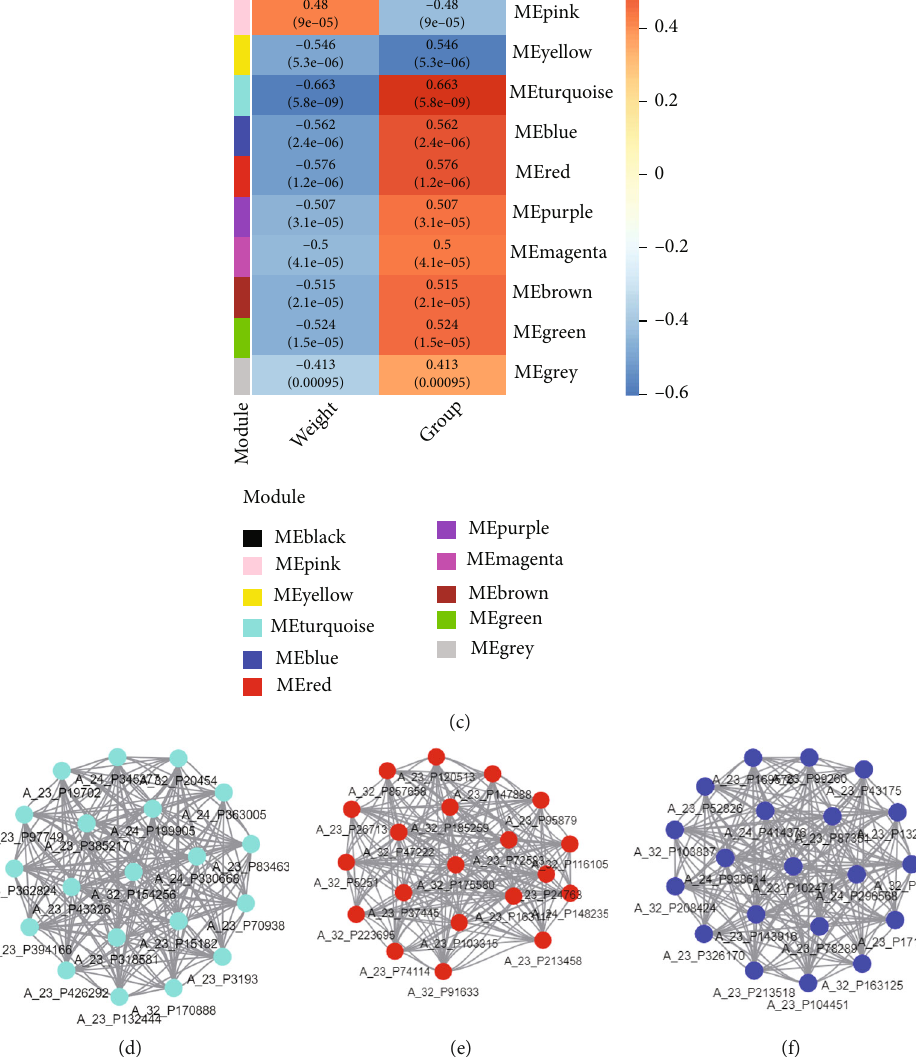
Figure 3: WGCNA analysis of gene expression pro fi les in CKD patients and healthy individuals. (a) Sample hierarchical clustering dendrogram; (b) clustering dendrogram, di ff erent color blocks represent gene modules formed by dynamic tree cutting method; (c) gene module heatmap of correlations with clinical features. (d) Interaction network analysis is performed in the turquoise module. (e) Interaction network of red modules. (f) Interaction network of blue